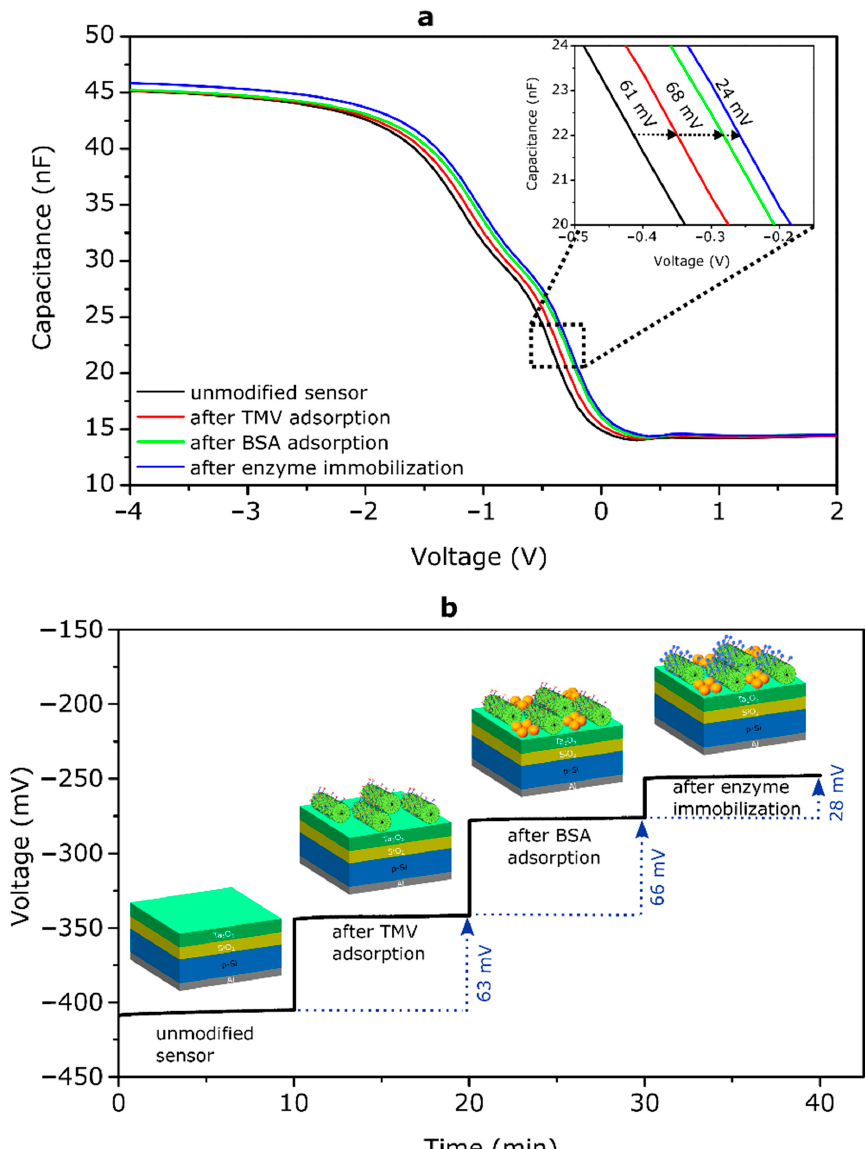
Figure 7. ( a ) C–V curves and ( b ) ConCap signals of an EIS sensor before and after each surface modification step (unmodified sensor, after TMV adsorption, after BSA adsorption, after enzyme immobilization).